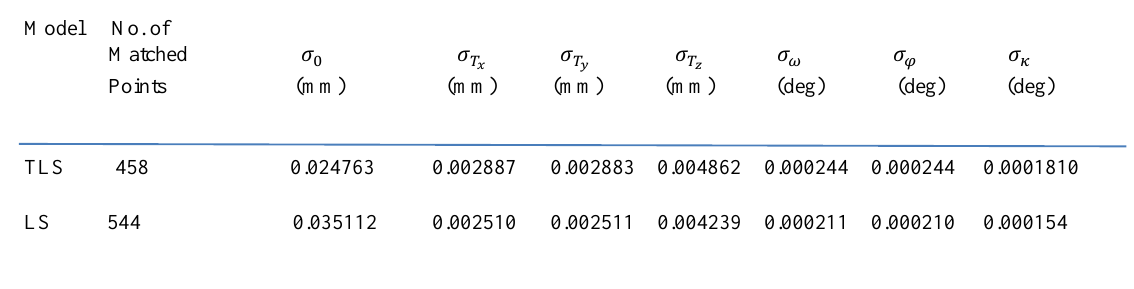
Table 1. Numerical results of ‘surface patch’